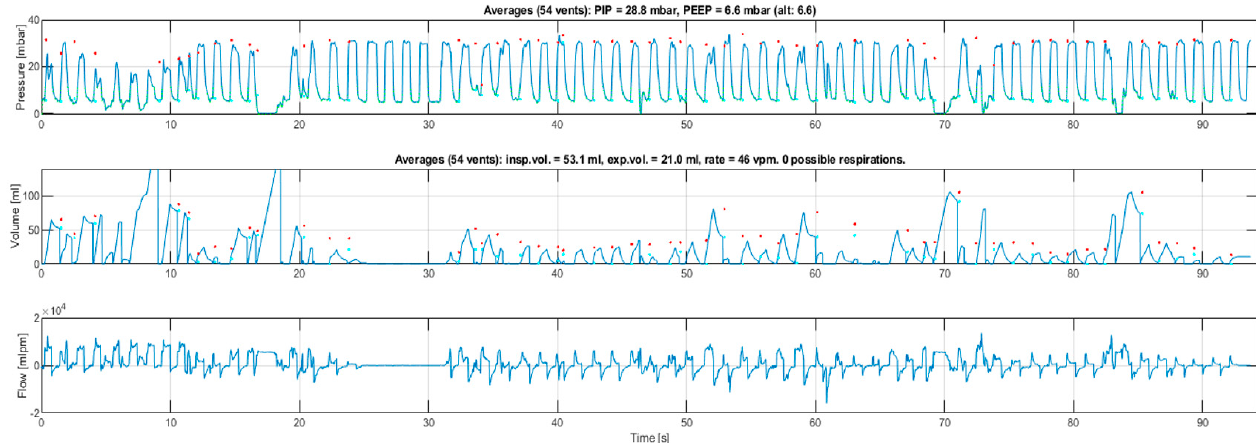
Figure 2. Graphical respiratory function monitor output from a clinical ventilation sequence. The upper curve shows peak inflating pressure, generally maintained around 30 mbar (1 mbar = 1.02 cmH 2 O and the units are used interchangeably in this article). The second curve shows tidal volume (mL); the discrepancy between inflated and expired volumes is due to mask leak. The third curve shows gas flow (mL/min), with positive values indicating flow towards the neonate and negative values indicating flow away. The volume and flow curves disappear while pressure is maintained between 25–30 s, indicating obstruction to gas flow which is rapidly corrected.